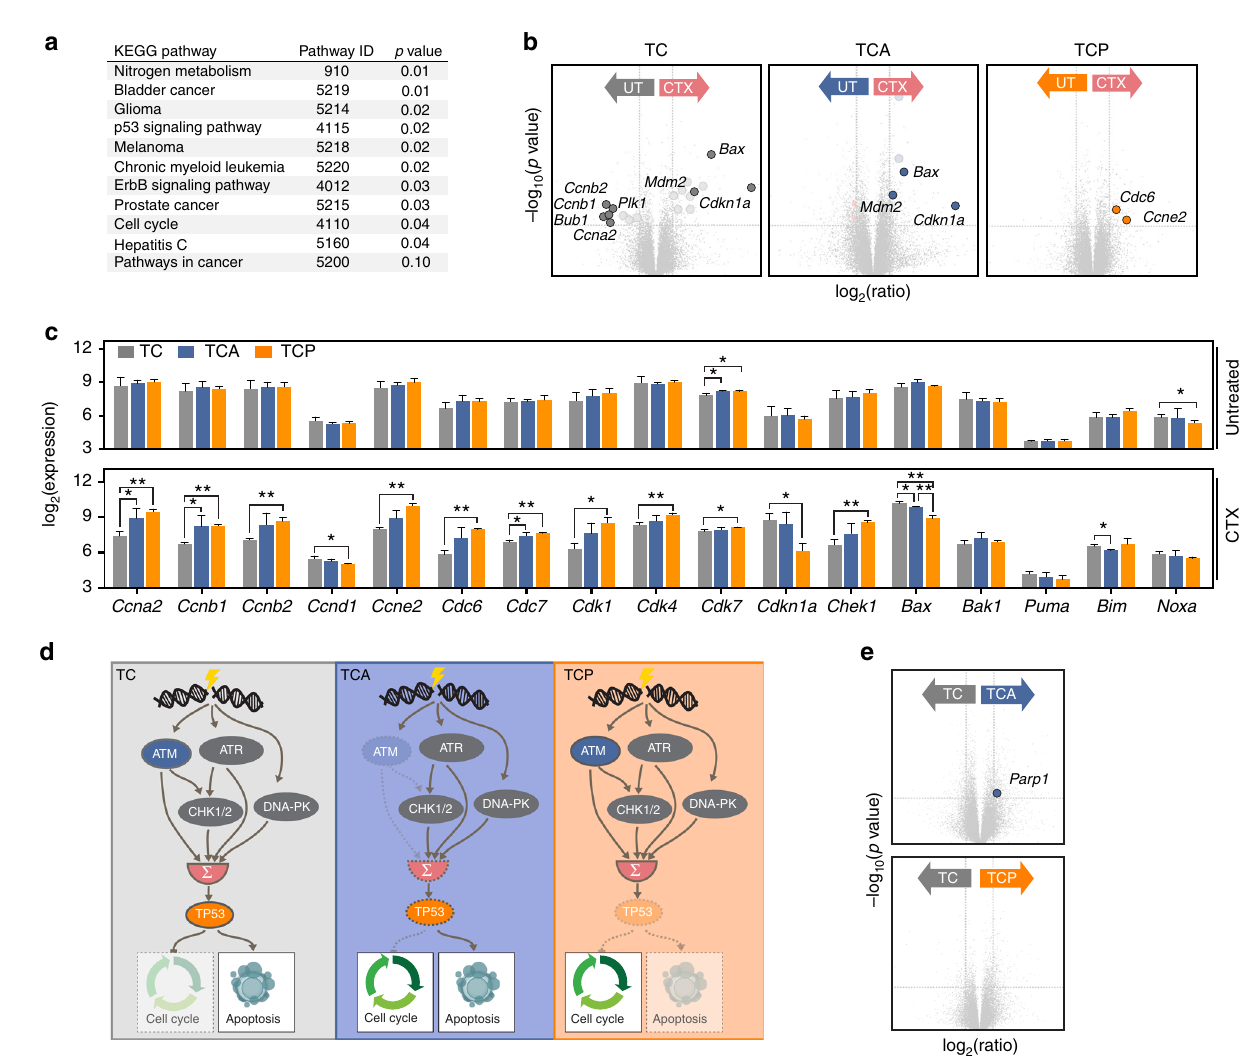
Fig. 4 Apoptosis and cell cycle control are rewired in cyclophosphamide-treated TCA and TCP mice. Cyclophosphamide treatment induces a robust p53 response in CLL cells isolated from TC animals, evidenced by transcriptional upregulation of the p53 target genes Mdm2 , Bax , and Cdkn1a . S-phase cyclins and mitotic genes are downregulated in cyclophosphamide-treated TC-derived CLL cells. In contrast, TCA animals lack a detectable repression of S-phase cyclins and mitotic genes in response to cyclophosphamide. Furthermore, TCP-derived CLL cells lack a transcriptional signature of a p53 response, fail to downregulate S-phase cyclins and mitotic genes and instead display an increased expression of the S-phase genes Cdc6 and Ccne2 . a Signi fi cantly differentially expressed KEGG pathways between CLL cells isolated from spleens of untreated ( n = 3 for TC, TCA, and TCP) and cyclophosphamide-treated animals ( n = 3 for TC, TCA, and n = 2 for TCP) of all three genotypes. Splenocytes were isolated 12 h after a single dose of 200 mg/kg cyclophosphamide. b Differentially expressed genes between untreated and treated samples of each genotype. Signi fi cantly differentially expressed components of the KEGG pathways “ p53 signaling pathway ” and “ cell cycle ” are highlighted ( transparent circles ) and a selected set of these genes was annotated ( colored circles ). A complete list of the signi fi cantly and differentially expressed genes is provided in Supplementary Table 1. c Expression levels of cell cycle and apoptosis genes in splenocytes of untreated and cyclophosphamide-treated animals (genotype-strati fi ed). d Simpli fi ed illustration of the cellular response to genotoxic stress observed in leukemic clones that develop in TC, TCA, a`nd TCP animals. Integrated signals from multiple pathways activated by DNA damage lead to the activation of p53, which mediates cell cycle arrest and apoptosis. This p53-mediated response is partially impaired in Atm -de fi cient cells and completely abolished in the p53 -de fi cient setting. e Signi fi cantly differentially expressed components of the base excision repair ( BER ) pathway between the different genotypes are highlighted . A complete list of differentially expressed genes of the KEGG pathway “ base excision repair ” is provided in Supplementary Table 2. Error bars represent standard deviation. Student ’ s t- test, * p ≤ 0.05, ** p ≤